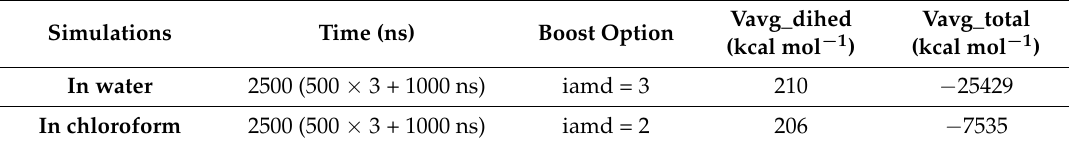
Table 4. Summary of various accelerated molecular dynamics